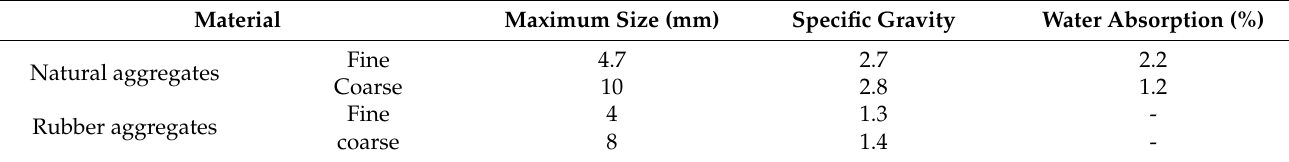
Table 2. Physical properties of the rubber aggregates compared to the natural one.